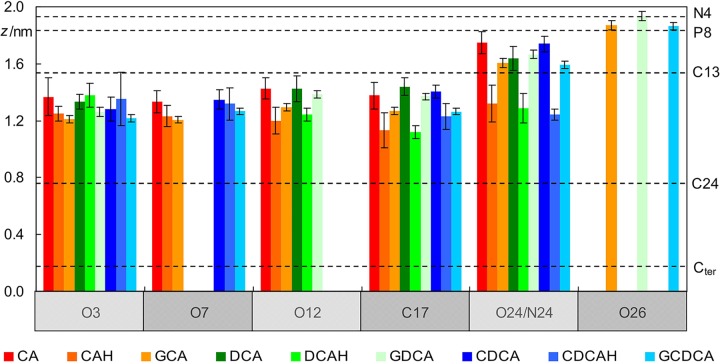
Average location of selected POPC (dashed horizontal lines; please refer to Figure 1 for numbering) and BS atoms (vertical bars) during the simulations (see Figure 1 for atom numbering).